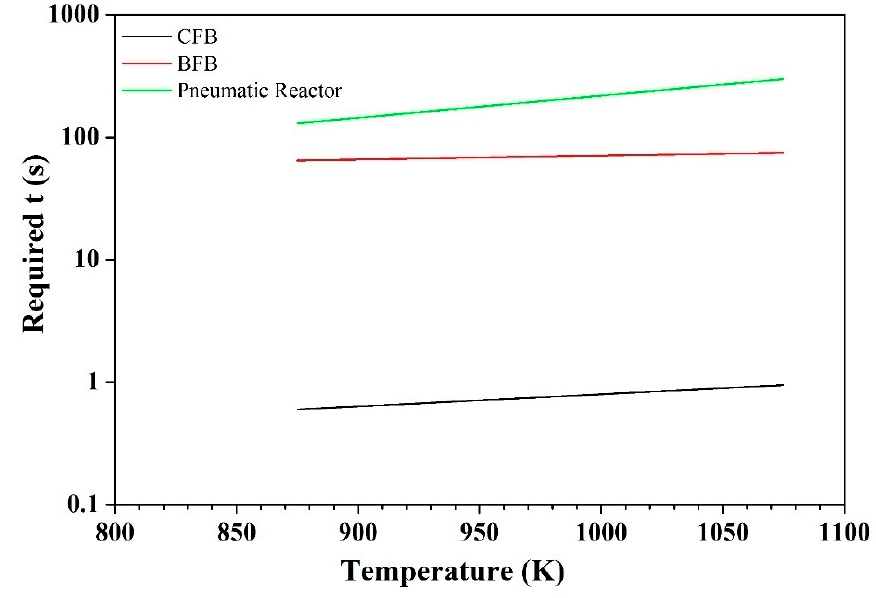
Figure 9. Theoretical contact time vs. Temperature with CaO, for a removal efficiency of 95% in a bubbling fluidized bed (BFB), CFB, and pneumatic reactor.